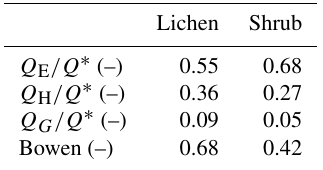
Table 3. The average partitioning of net radiation over the three fluxes and the average Bowen ratio ( Q H /Q E ) for the three paired lichen and shrub plots of 2019. See Appendix G for the calculation and additional